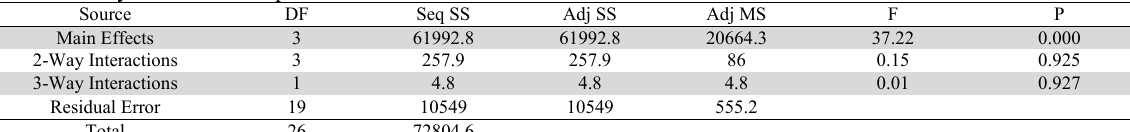
Variance analysis for the total profit